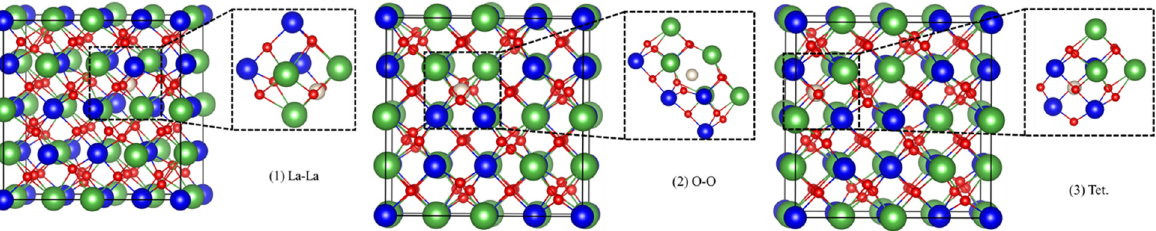
Figure 1. The structure of He–La 2 Zr 2 O 7 system for initial state. The green, blue, red and ivory spheres represent La, Zr, O and He atoms, respectively. ( 1 ) La–La (He atom at the midpoint of two lanthanum atoms), ( 2 ) O–O (He atom at the midpoint of two oxygen atoms), ( 3 ) Tet. (He atom at the tetrahedral location).